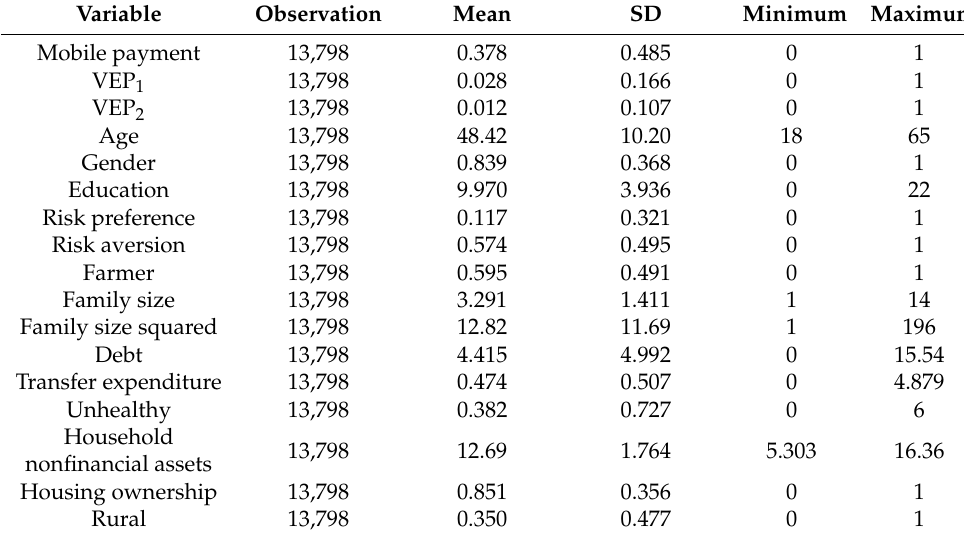
Table 3. Variable descriptive